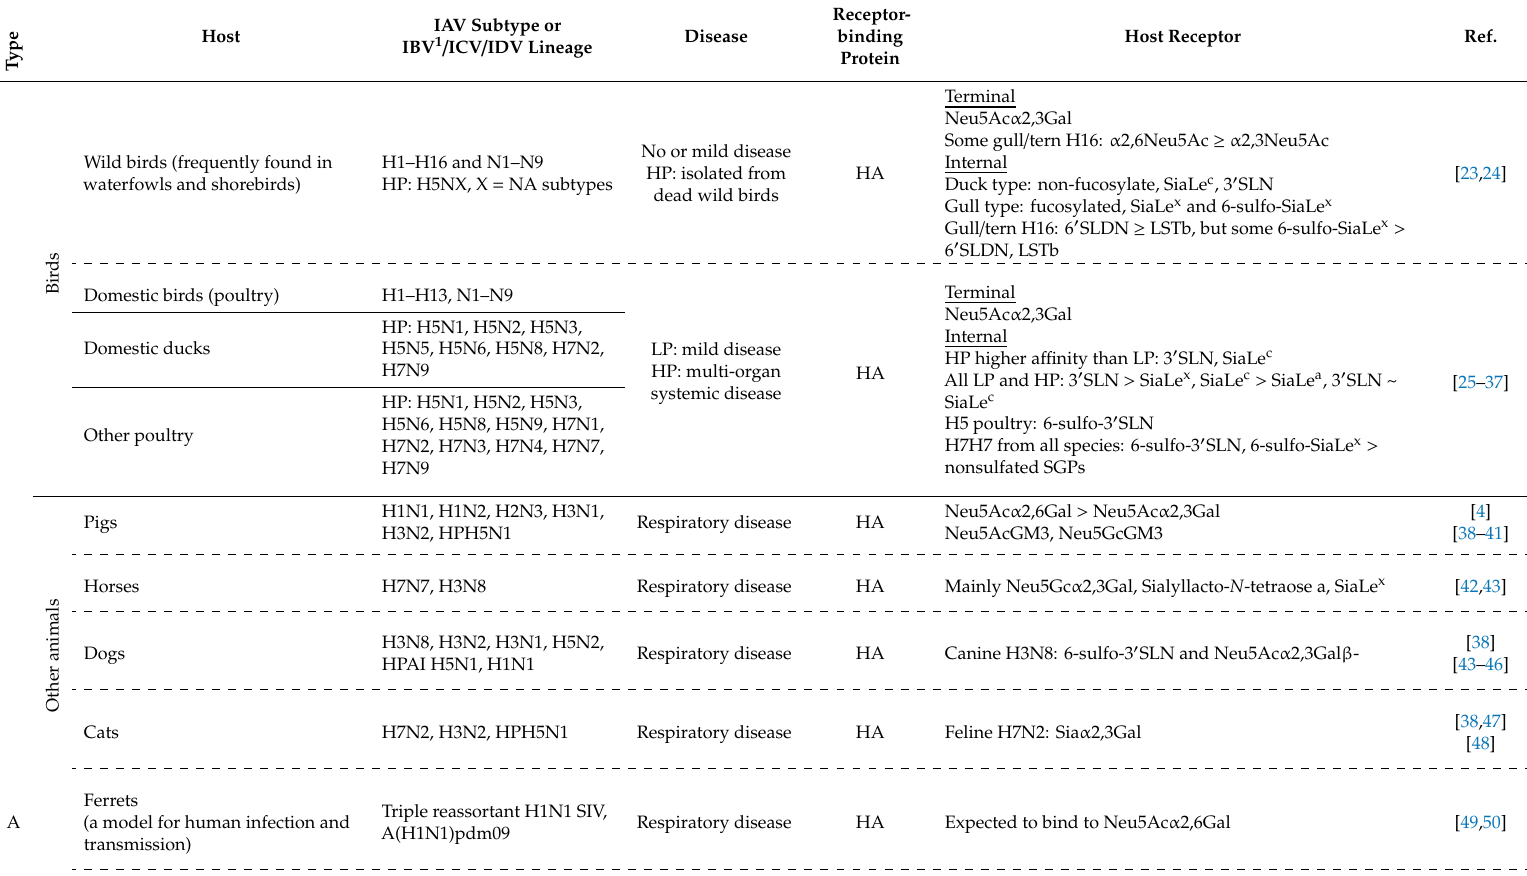
Table 1. Host range, viral receptor-binding glycoproteins and host receptors of influenza